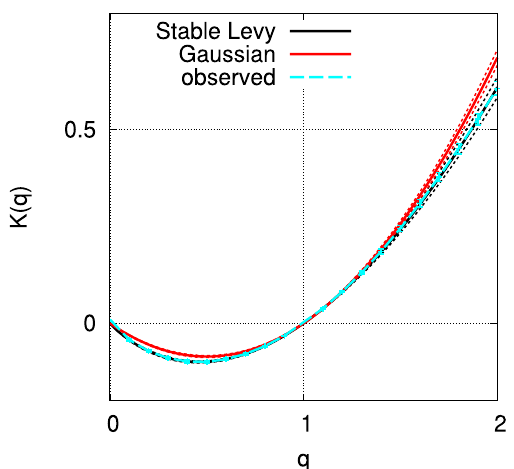
Figure 5. Moment scaling exponent K ( q ) for observational data (cyan). Best-fitting multifractal model with stable Lévy generators (black), and with Gaussian generators (red). Each error bar in cyan shows the standard deviation for the fitting of K ( q ). Dotted lines in black and red indicate the ranges of error due to the uncertainty of parameters in the corresponding